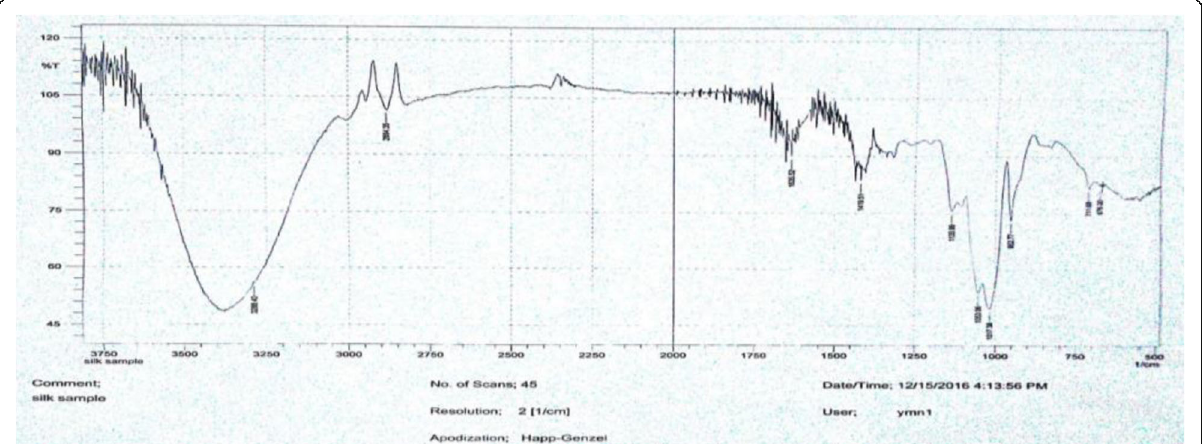
Fig. 3 FT-IR spectrum of bioactive fraction of Pardosa brevivulva silk